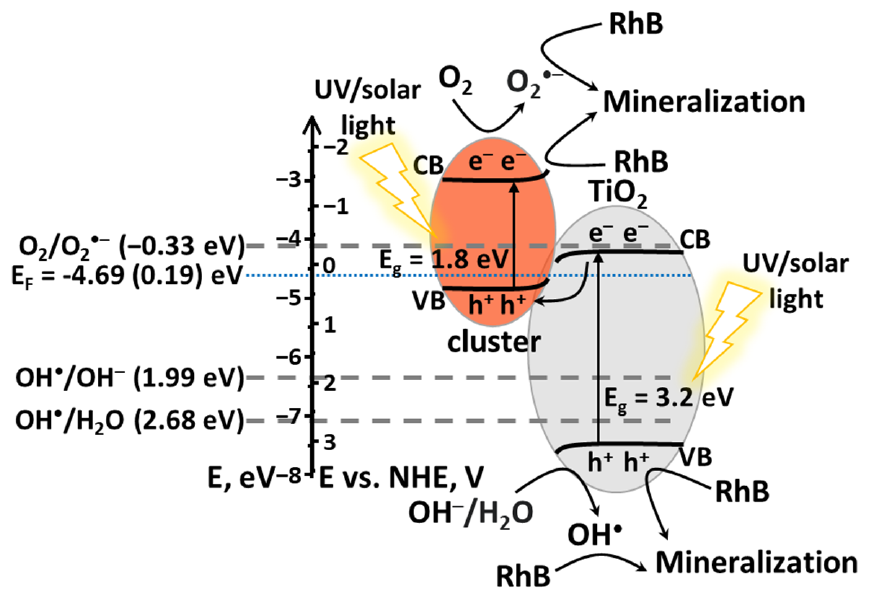
Figure 10. Schematic representation of S-type heterojunction photocatalytic mechanism for n 0.1 @TiO 2